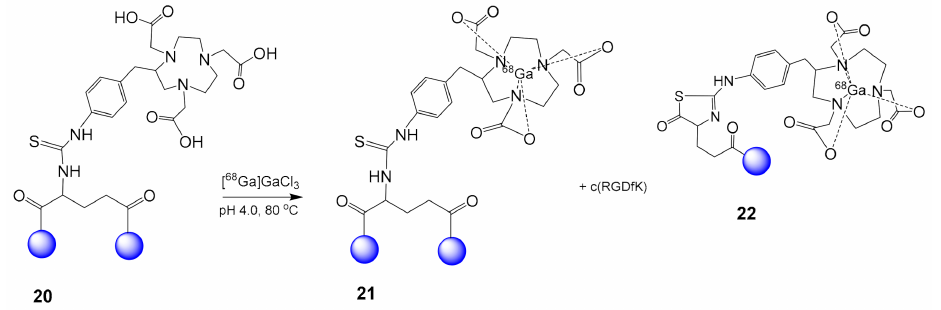
Figure 7. Instability of [ 68 Ga]Ga-NOTA-E(c(RGDyK)] 2 21 observed during its preparation from 20